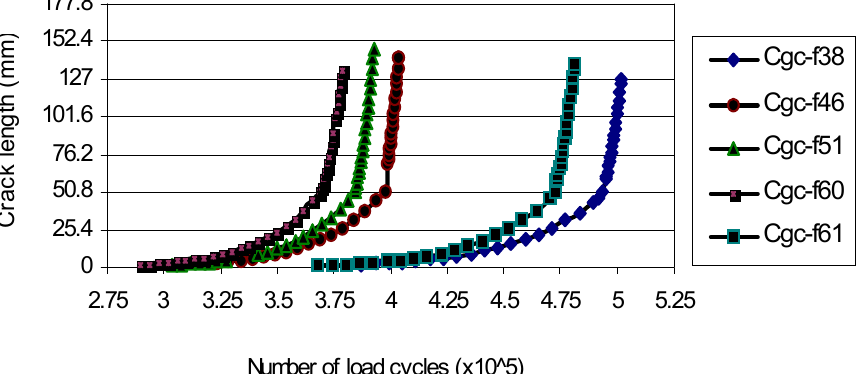
Fig 5. Crack growth history data of corroded specimens